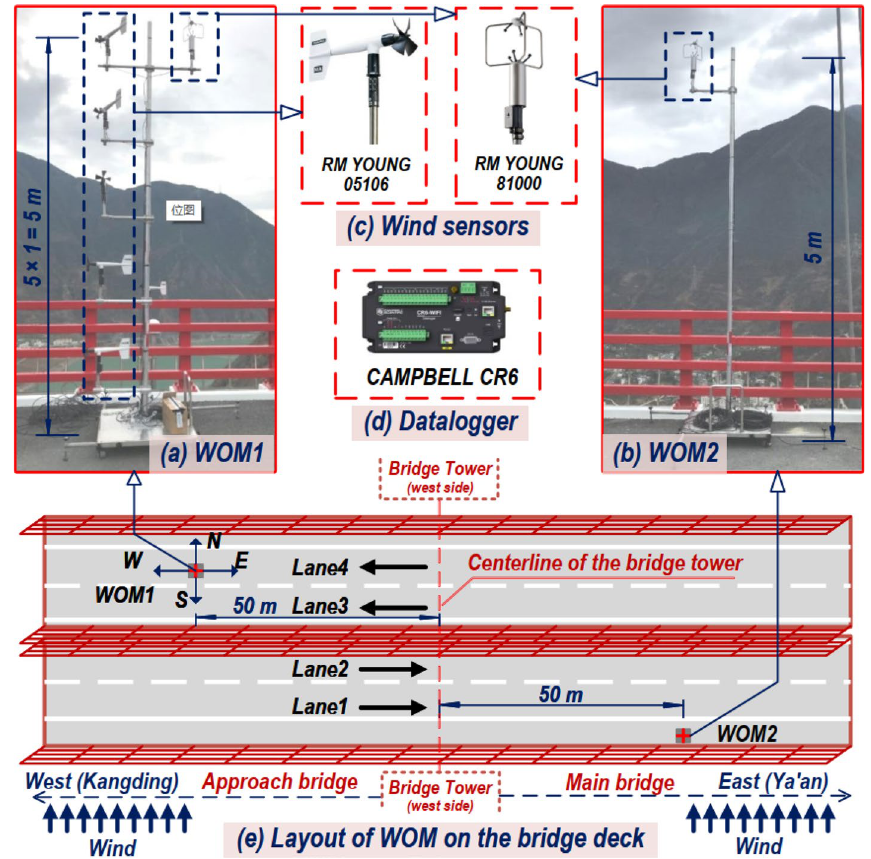
Figure 2. Monitoring system of wind environment on bridge deck: ( a ) WOM1, ( b ) WOM2, ( c ) wind sensors, ( d ) datalogger, ( e ) layout of WOM on the bridge